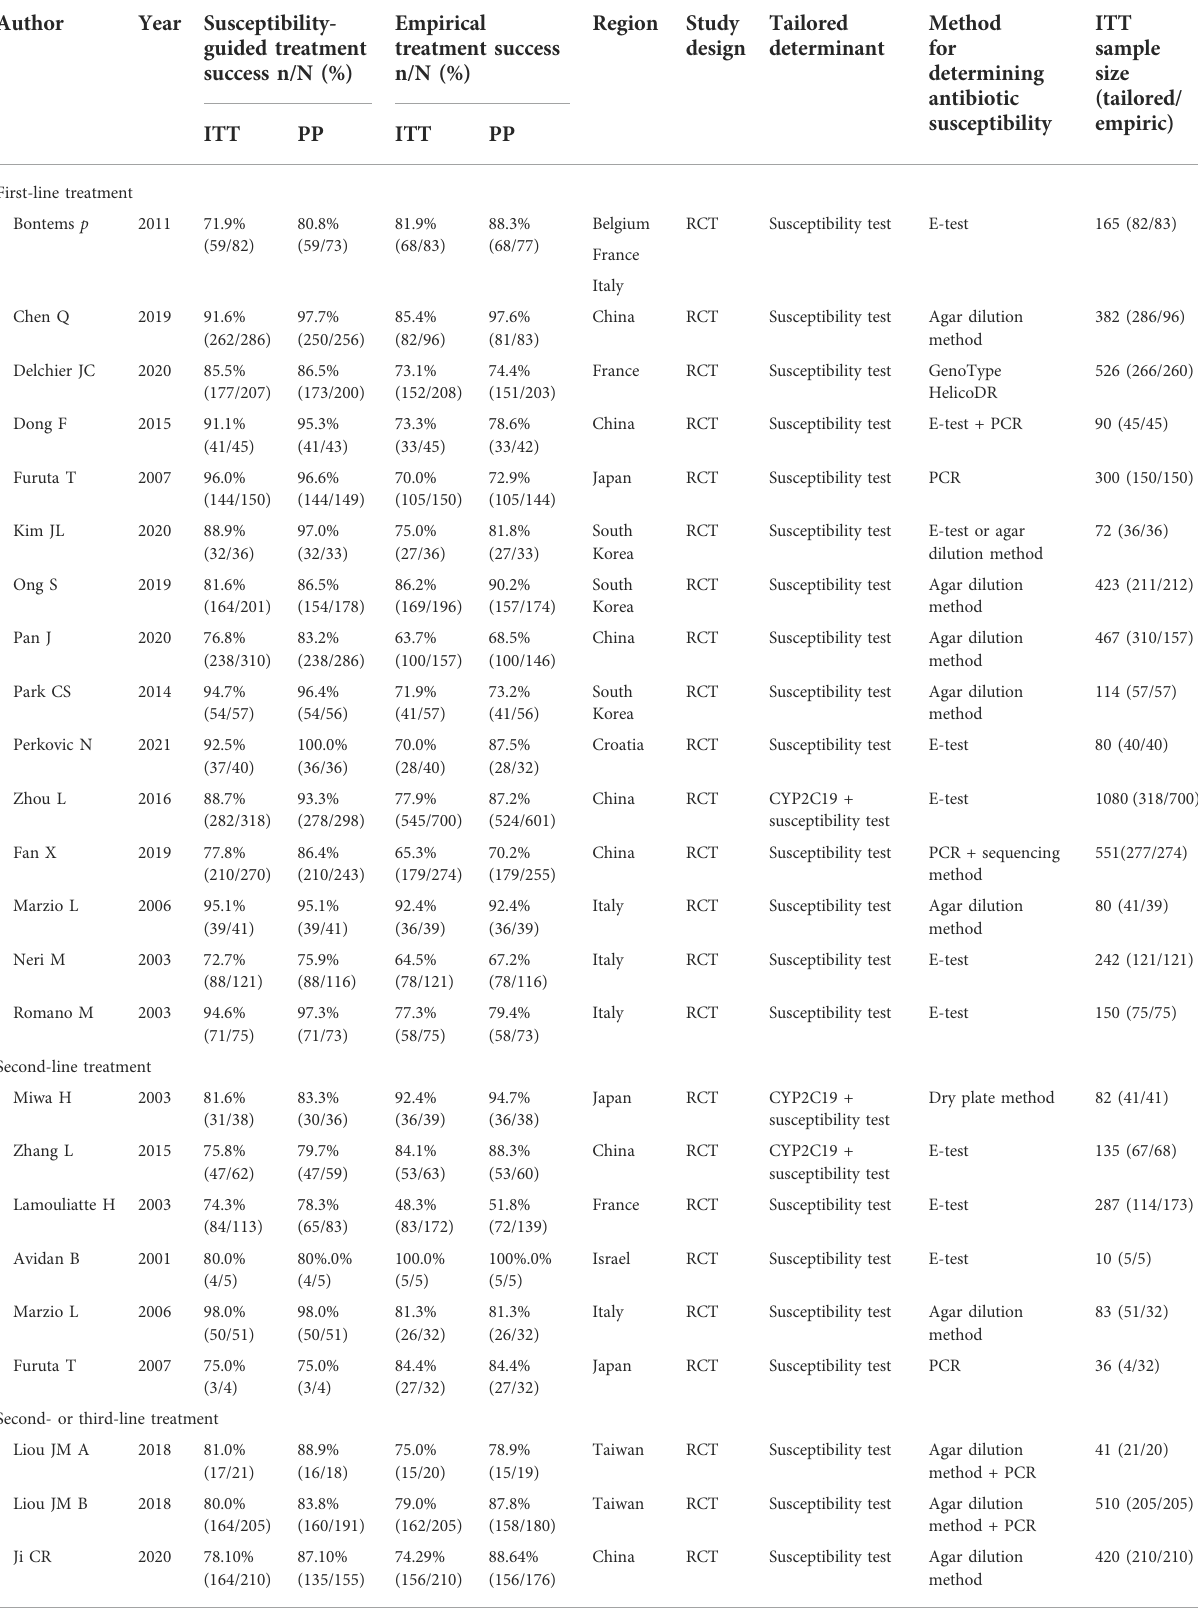
TABLE 1 Characteristics of studies